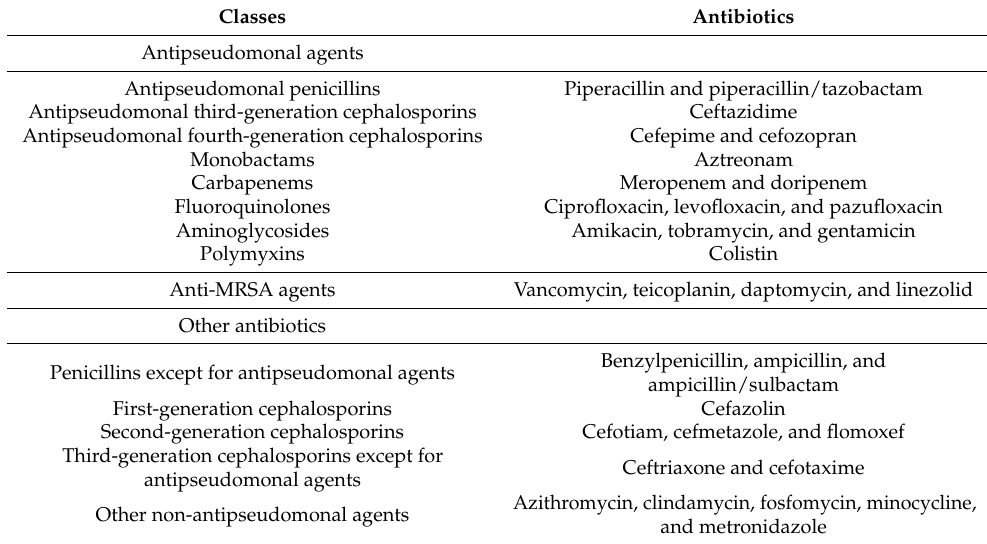
Table 1. Classification of antibiotics available at Kobe University